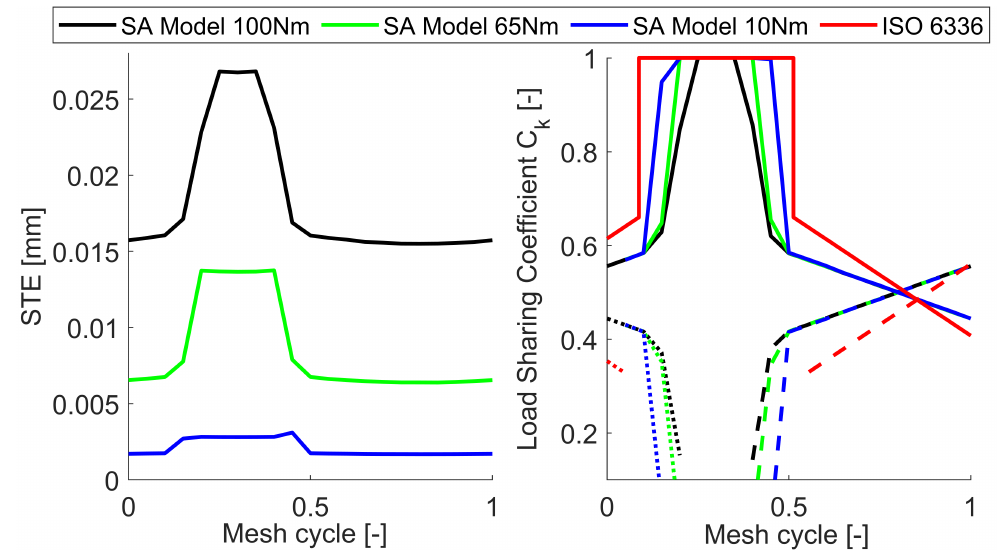
Figure 14. STE and LSF of the tested gear pair without modifications.